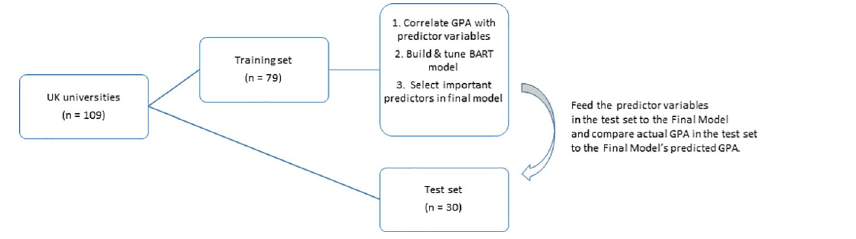
Fig 1. Schema of the analysis